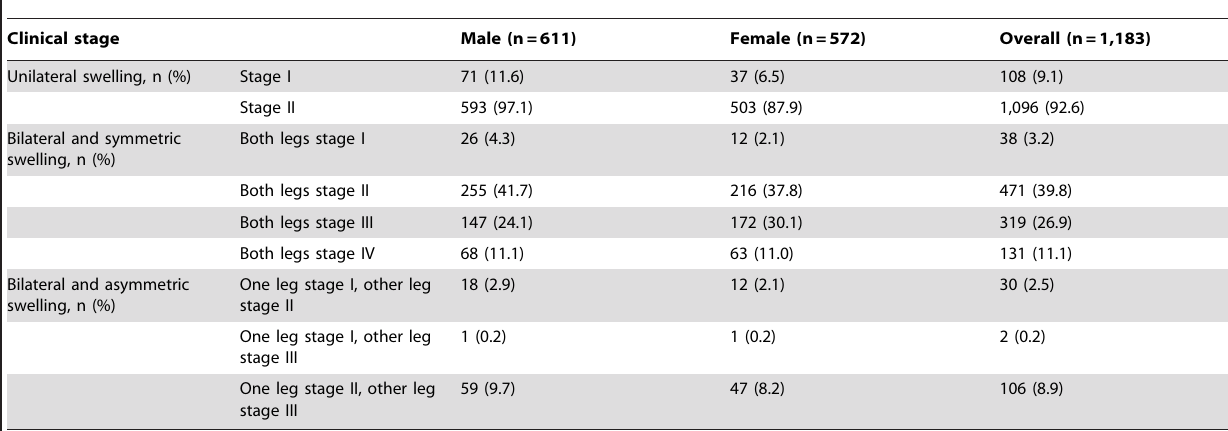
Table 3. Clinical stages of podoconiosis among the study subjects.